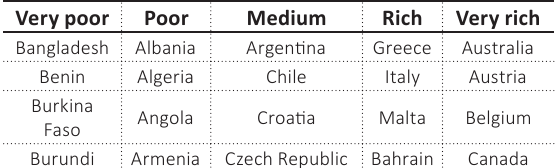
Table 2. Example countries by the category of